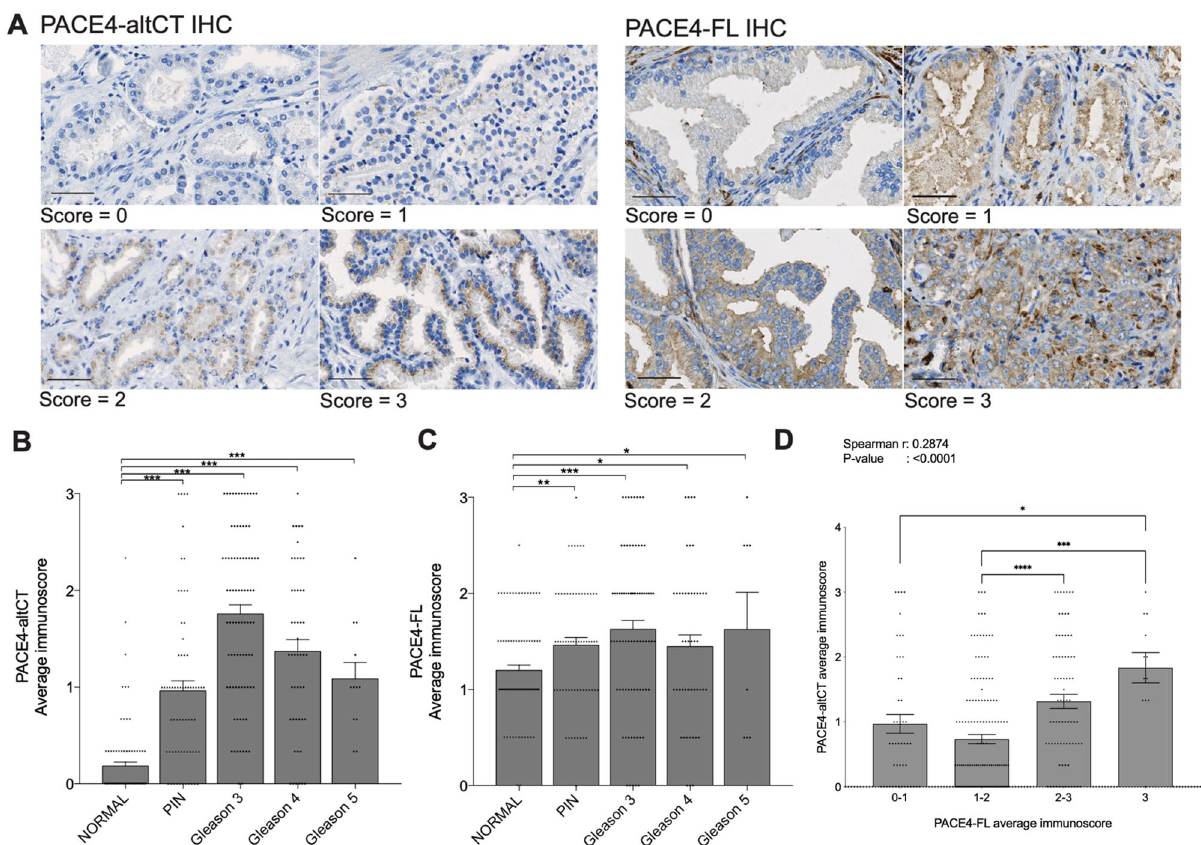
Figure 2. PACE4 isoforms immunohistochemical analysis of PCa specimens. ( A ) Representative images of prostate epithelial cells stained for either PACE4-altCT or PACE4-FL with the different scoring units used. Magnification: 20 ×, scale bars represent 50 µm. A 40 × magnification figure is also found in Supplementary Fig. 1 to encompass cellular localization of immunohistochemical signal. ( B ) Averaged immunoscores for PACE4-altCT on the TMA cores of normal (n = 92), PIN (n = 67), Gleason 3 (n = 85), 4 (n = 49) and 5 (n = 12). Gleason scores are the primary Gleason pattern for each patients. Data are means ± SEM, all individual data are shown as dots. ( C ) Averaged immunoscores for PACE4-FL on the TMA cores of normal (n = 88), PIN (n = 64), Gleason 3 (n = 79), 4 (n = 47) and 5 (n = 8). Differences between the number of patients analyzed for this figure compared to PACE4-altCT (Fig. 2B) are due to core detachment and/or histological differences on successive slides. ( D ) Plots of immunoscoring for PACE4-altCT and PACE4-FL immunoscores for each tumor scored. The Spearman correlation r is calculated from the entire data set without regrouping scores together in intervals, histogram are means ± SEM. Statistical analysis is based on One-way ANOVA.